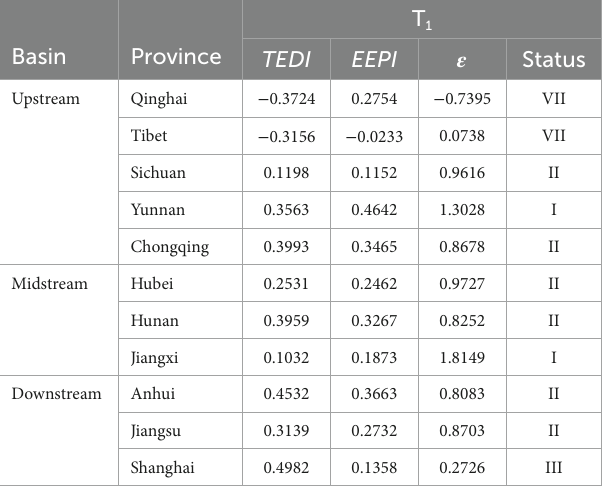
TABLE 3 Dynamic decoupling analysis of tourism economic development and ecological environment pressure in the Yangtze River basin from 2000 to